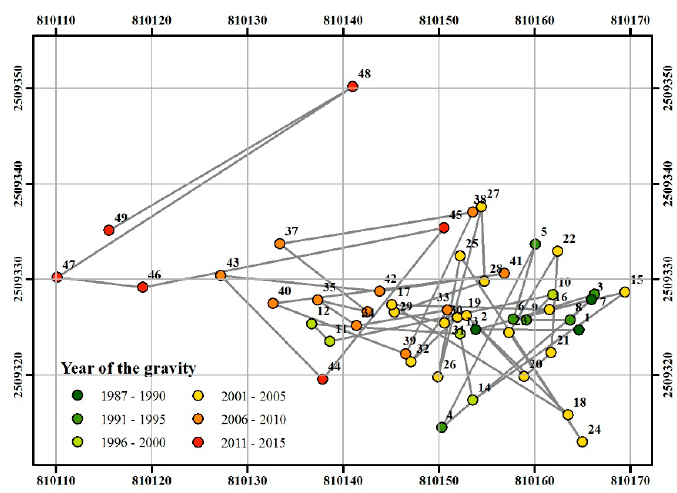
Figure 6. Movement track of the gravity center of land surface temperature. Remote Sens. 2017 , 9 , 919